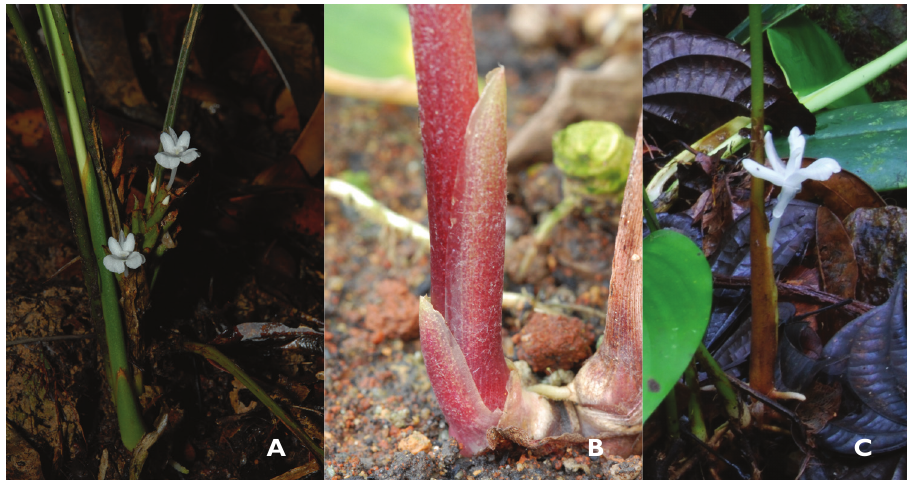
B Figure 4. Bladeless sheaths A Green and coriaceous in Scaphochlamys klossii (Peninsular Malaysia) B Red and coriaceous in Scaphochlamys abdullahii (Peninsular Malaysia) C Papery and marcescent in Borneocola calcicola (Sarawak). (Photographs by Y.Y. Sam).